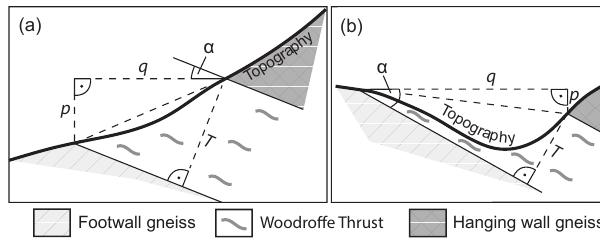
Figure 4. Schematic illustration of the trigonometry applied to quantify the true thickness of the Woodroffe Thrust mylonitic zone in a section perpendicular to strike. The parameters are defined in the main text. (a) Geometry applicable to locations 2–8 and 12–14 of Fig. 1. (b) Geometry applicable to location 11 of Fig.